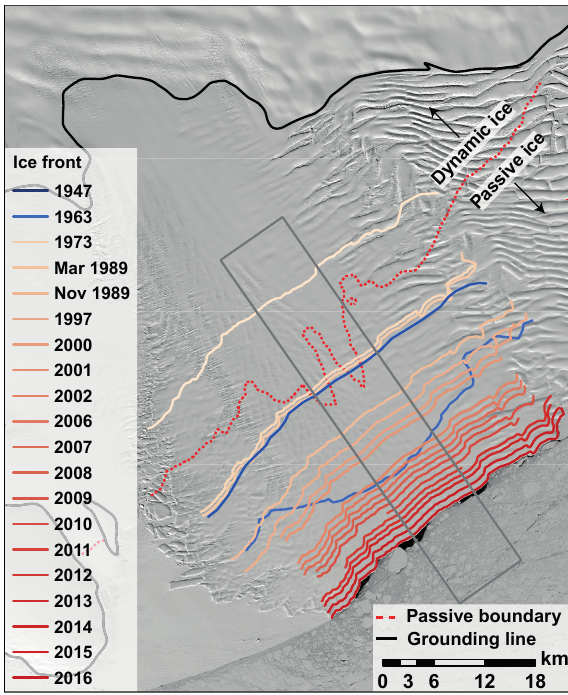
Figure 2. Mapped ice front position of the Cook East Ice Shelf be- tween 1947 and 2016, with the passive ice boundary overlain (Furst et al., 2016). Note that the 1973 ice front position of Cook East lies several kilometres inland of the passive ice boundary. The grey box delineates the region where ice front position change was cal- culated.